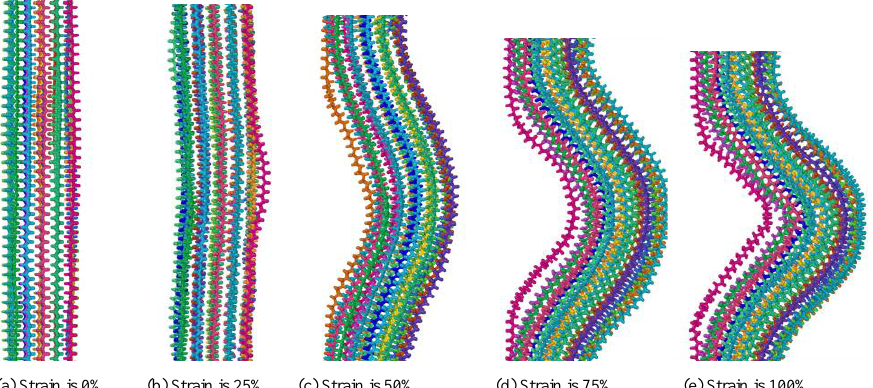
Figure 12. Tensile process of crystalline in the mixture polyethylene structure.